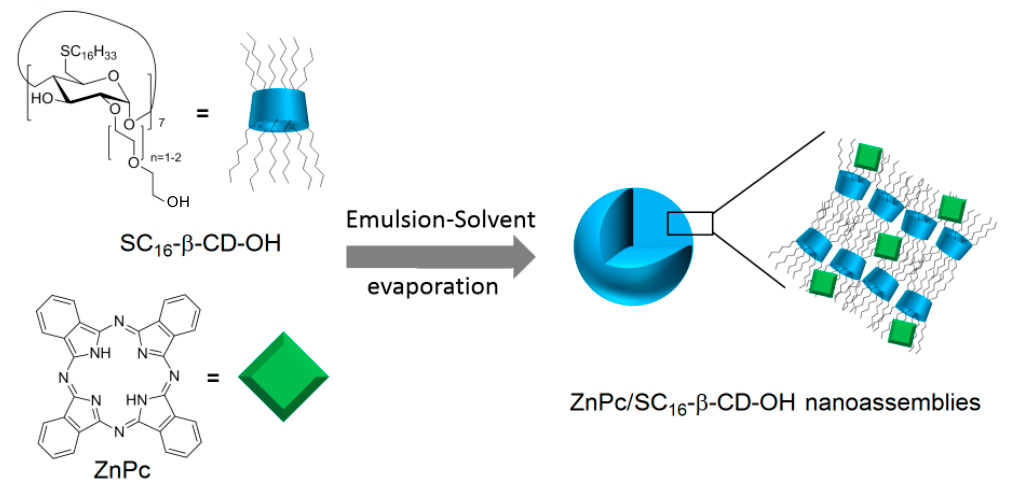
Figure 38. Molecular structure of SC 16 - β -CD-OH, ZnPc, and corresponding ZnPc/SC 16 - β -CD-OH nanoassembly. Adapted from Conte; Scala; Siracusano; Leone; Patane; Ungaro; Miro; Sciortino; Quaglia; Mazzaglia [166].